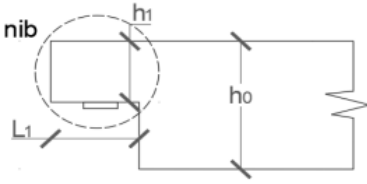
Figure 1. Geometry of a half-joint.